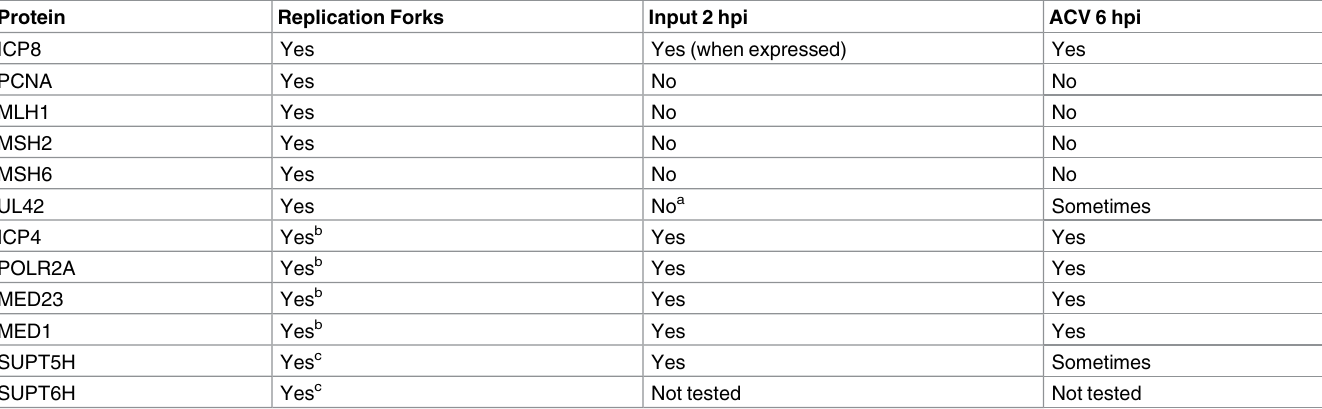
Table 1. Proteins that Colocalize with HSV-1 Replication Forks.